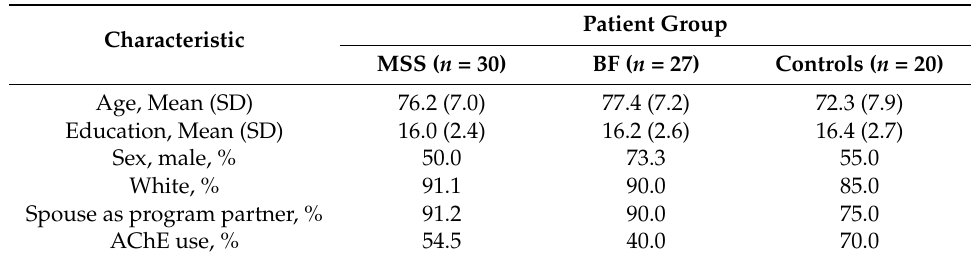
Table 1. Patient